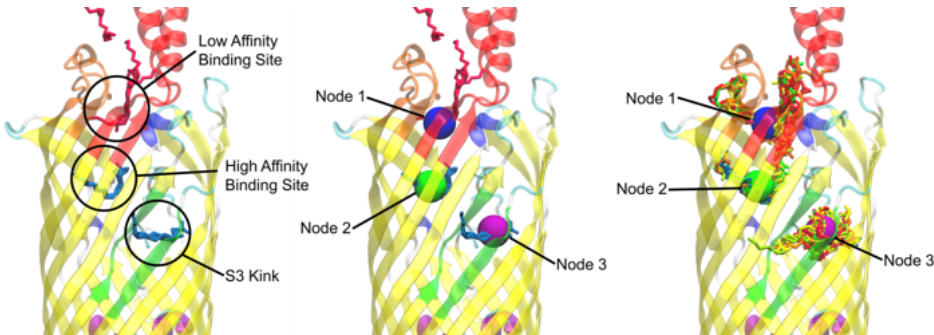
Figure 3. Mean shift based nodal analysis of the unequilibrated b2344 (RCSB ID 1T16) docking. ( Left ) the original detergents from the 1T16 X-ray structure and locations of the low affinity binding site, the high affinity binding site, and the S3 kink as described by van den Berg [27]. ( Center ) The location of the nodes found by the mean shift algorithm from computationally docked FAs, the 1T16 crystal structure bound detergents are also shown to validate nodal locations. ( Right ) Nodal locations and a snapshot of FA clusters from docking that the mean shift algorithm used to generate the nodes showing relatively good